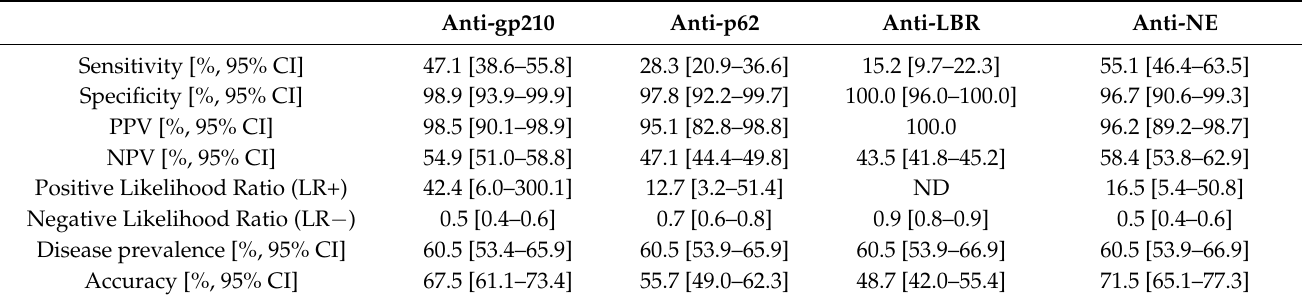
Table 2. Diagnostic accuracy for anti-p62 and anti-gp210 antibodies in PBC patients. Anti-gp210 Anti-p62 ND—not defined.